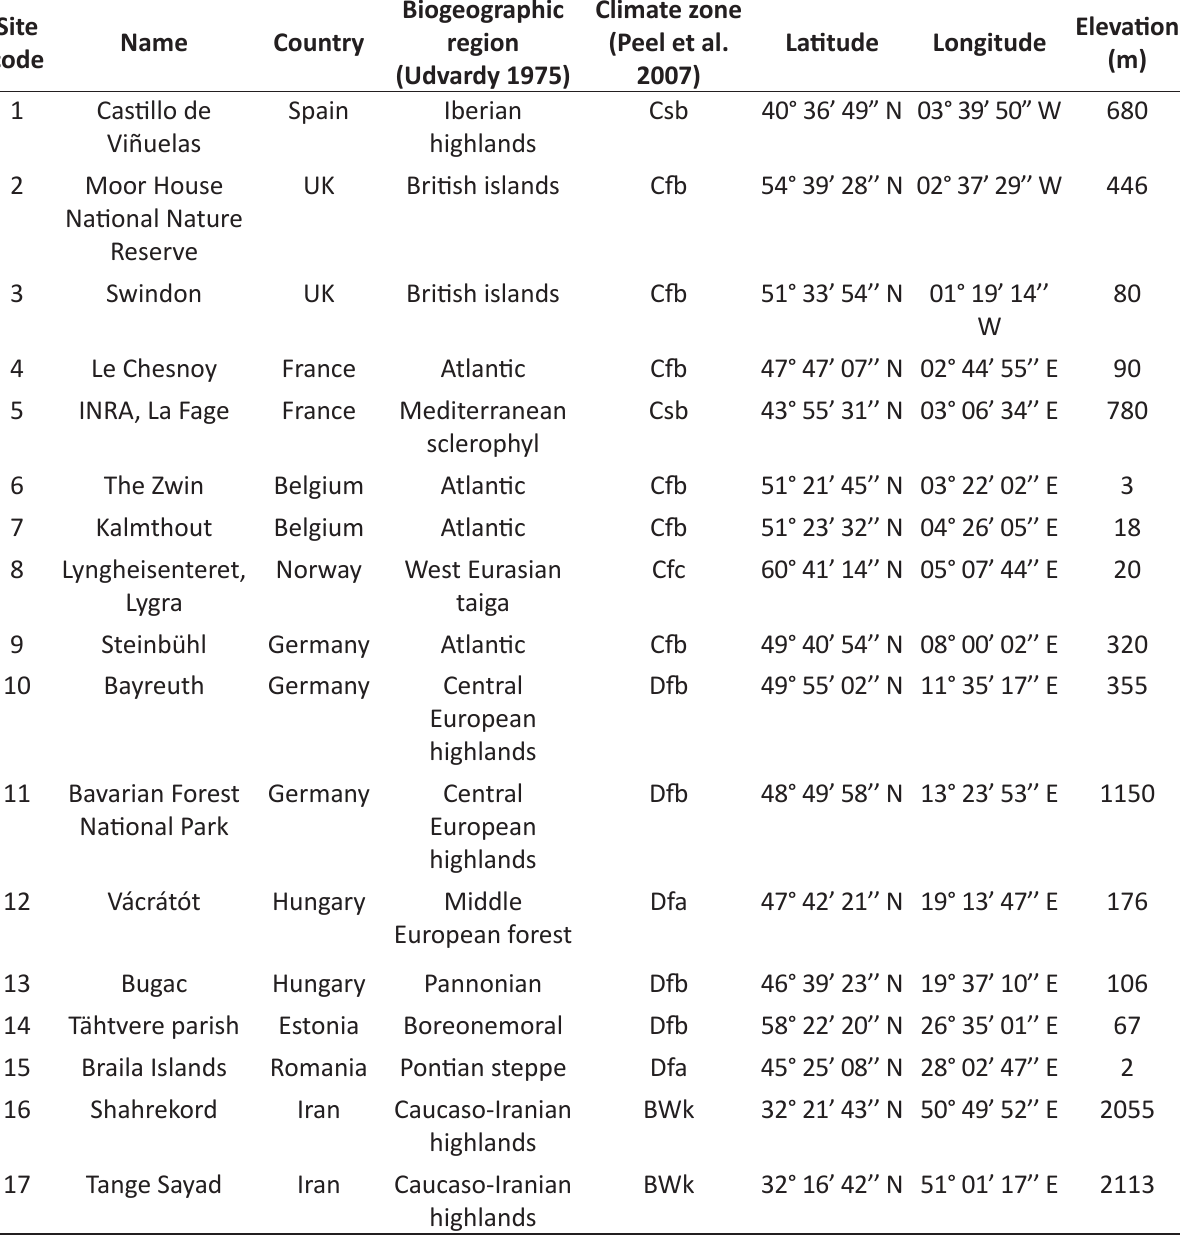
Table 1. Name, country and coordinates (latitude, longitude and elevation) of the study sites, and their classification in biogeographic regions (Udvardy 1975) and Köppen-Geiger climate zones (Peel et al. (2007), with BWk: cold desert climate, Cfb: warm summer maritime temperate climate, Cfc: cold summer maritime temperate climate, Csb: dry and warm summer Mediterranean climate, Dfa: hot summer continental climate, and Dfb: warm summer continental climate). Site codes match the numbers on the map in Figure